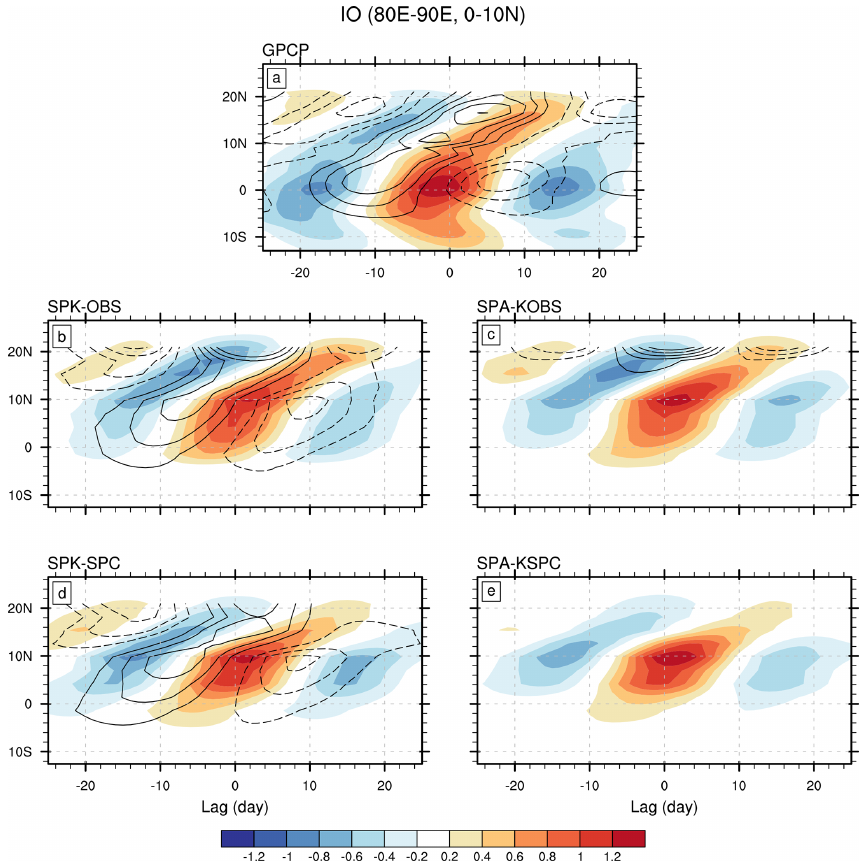
Figure 4. Lagged regression coefficients of 80–90 ◦ E averaged intraseasonal precipitation (shading; mmd − 1 (mmd − 1 ) − 1 ) and SST (contour; ◦ C(mmd − 1 ) − 1 ) onto (0–10 ◦ N, 80–90 ◦ E) averaged intraseasonal precipitation for (a) GPCP precipitation and ERAI SST, (b) SPK-OBS, (c) SPA-KOBS, (d) SPK-SPC, and (e) SPA-KSPC. Contour interval is 0.001 ◦ C(mmd − 1 ) − 1 , and zero contour is